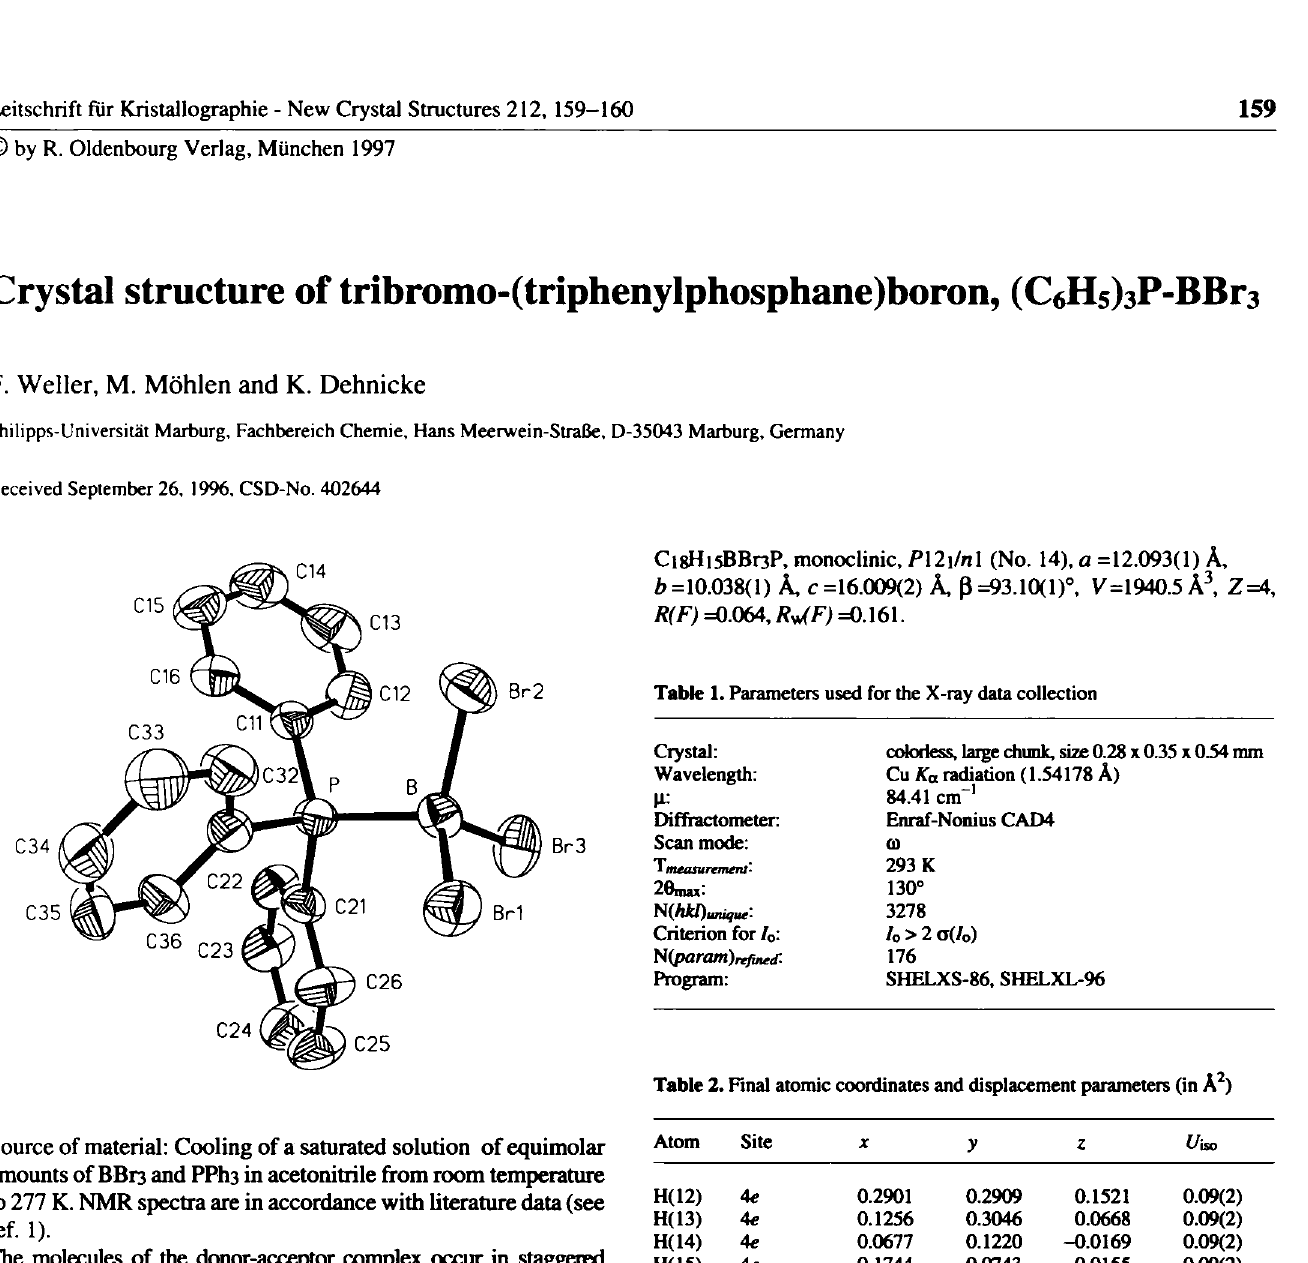
Table 3. Final atomic coordinates and displacement parameters (in A 2 ) Atom Site X